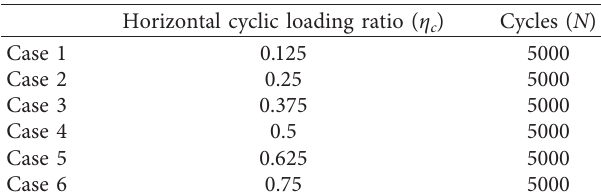
Figure 7: The curve of static loading-displacement. Table 3: Experiment conditions.